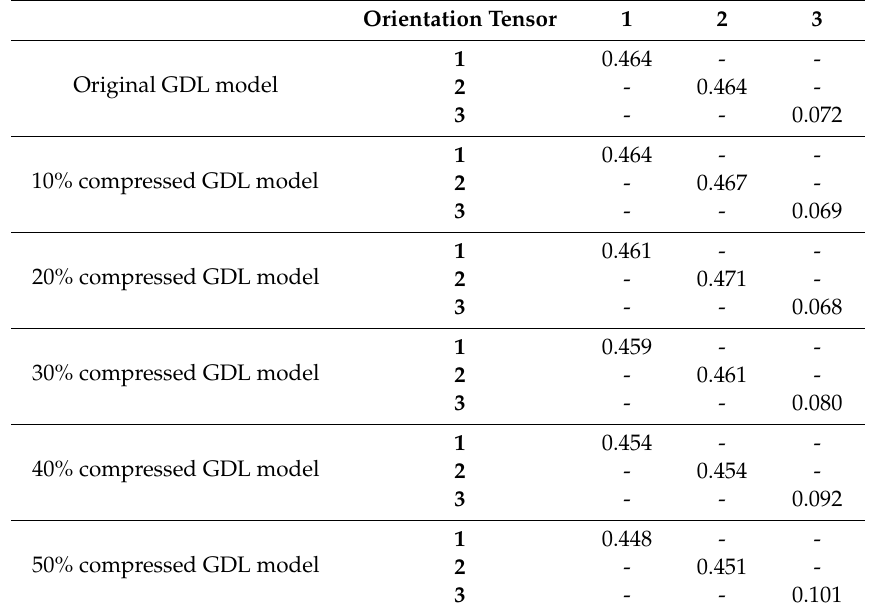
Table 2. Components of orientation tensors used for the generation of the model microstructures Orientation Tensor